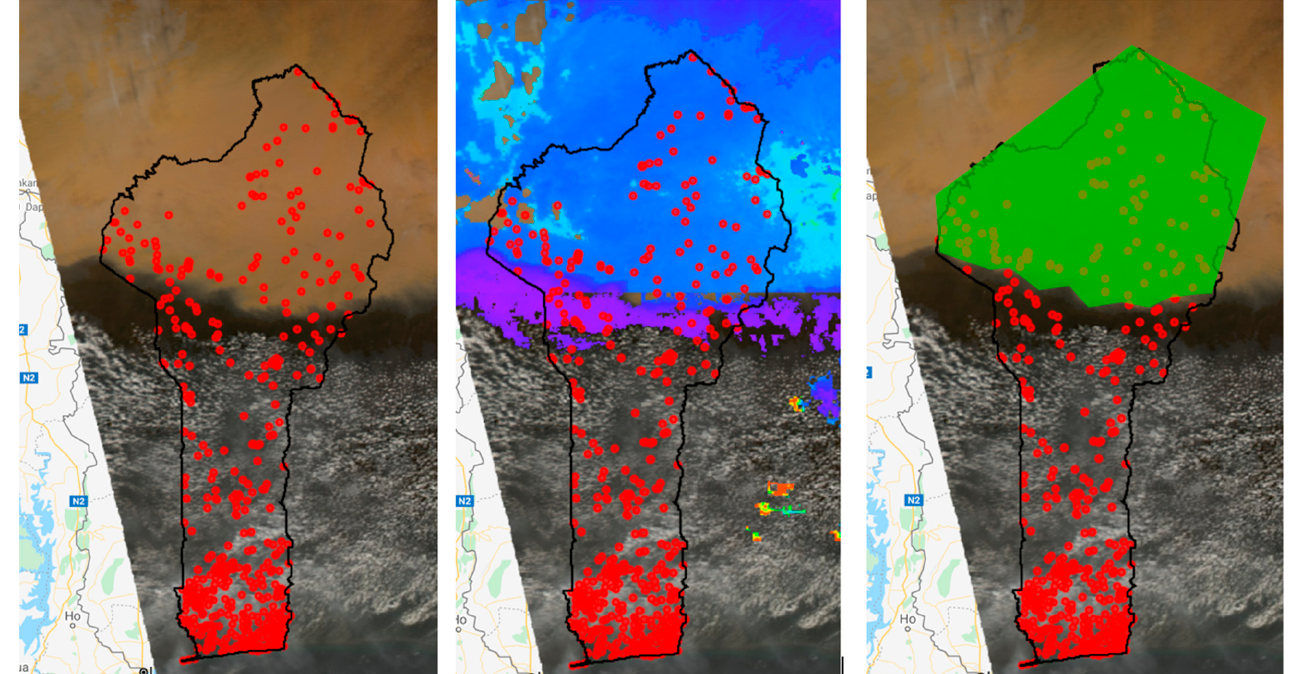
Figure 1. Satellite image of Benin with locations of each PSU (red circles). True-color image of a dust storm in Benin using the MYD09GA.006 Aqua Surface Reflectance Daily Global 1 km and 500 km resolution product ( left ). The same image with the Terra and Aqua MAIAC Land Aerosol Optical Depth 1 km added as a layer (showing the dust storm in blue, center ). The same image with the manually drawn polygon around the dust cloud and indicating the exposed PSUs within the polygon ( right ).